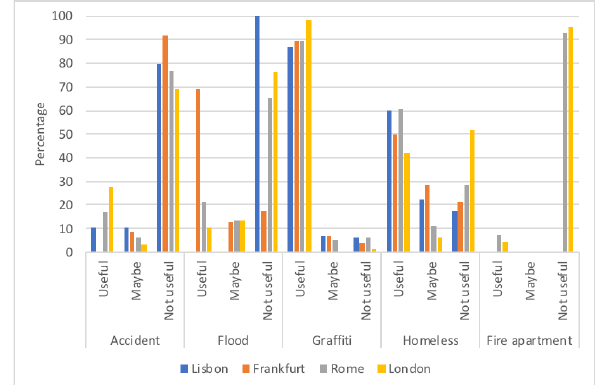
Figure 9. Percentage of photographs classified as “Useful”, “Maybe useful” and “Not useful” by keyword and city.